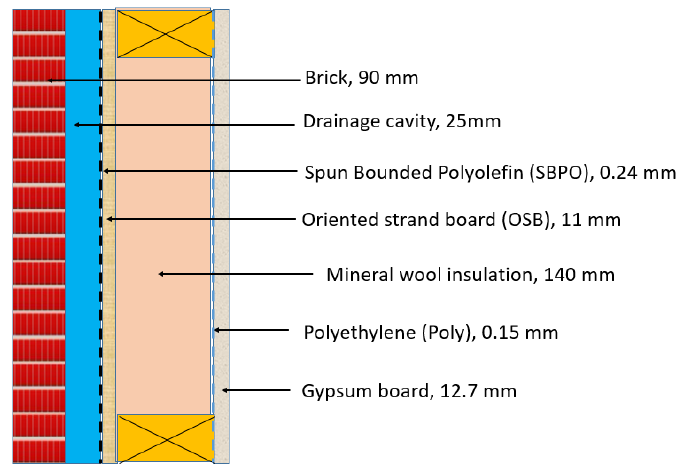
Figure 1. A typical wood-frame wall